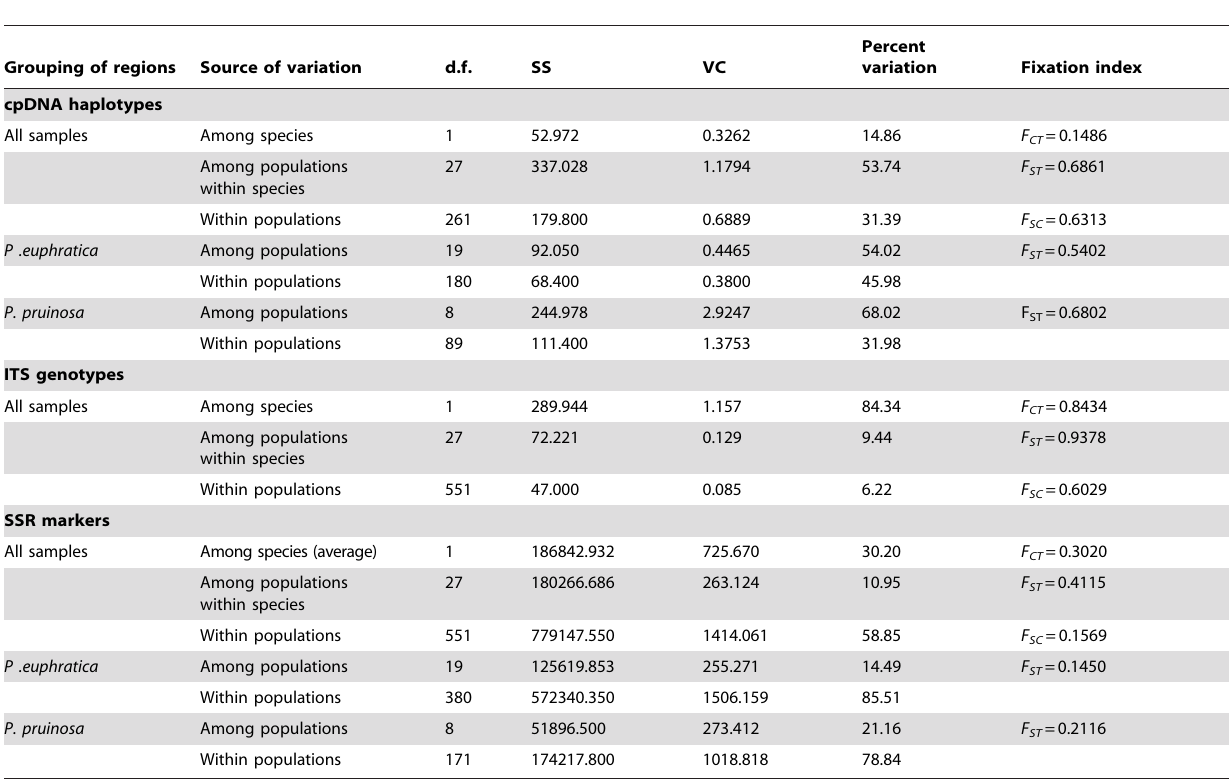
Table 2. Analyses of molecular variance (AMOVA) in the two poplar species based on cpDNA haplotypes, ITS genotypes and SSR